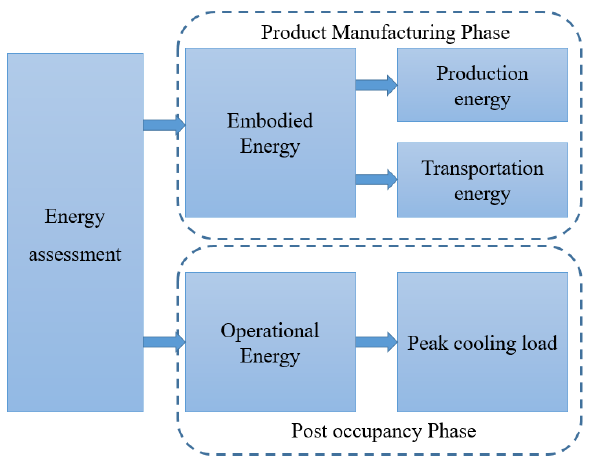
Figure 14. Flowchart for energy assessment.